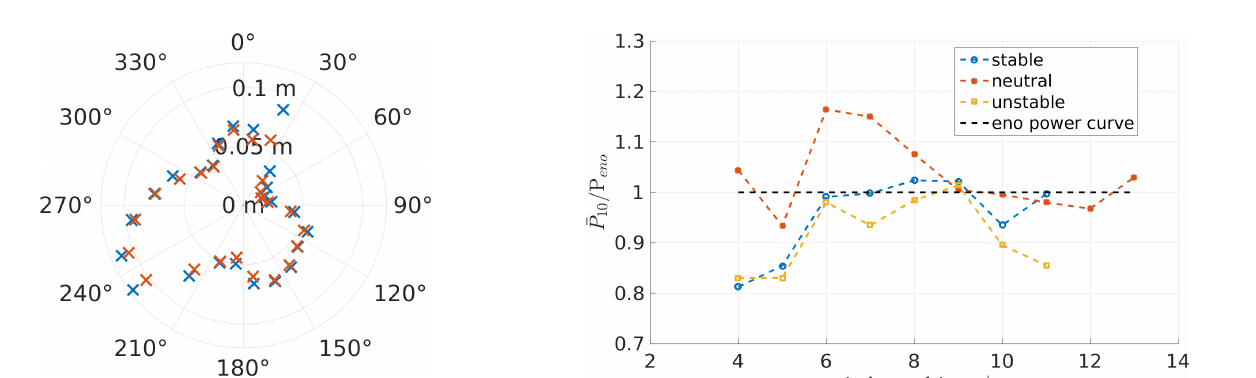
Figure 7. Power data determined from the measurement data for May/June 2017, normalised by the corresponding power of the eno114 3.5MW power curve determined by FAST in laminar con- ditions, for different stabilities (determined from eddy-covariance data). (cid:104) u ∗ ln( z 0 ,j ) (cid:105) (cid:104) u ∗ (cid:105) per